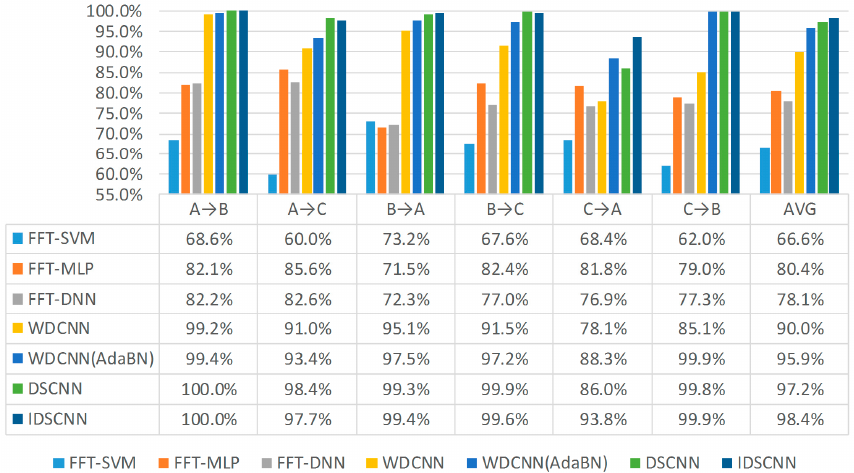
Figure 8. Comparison with other fault diagnosis models. Sensors 2017 , 17 , 1729